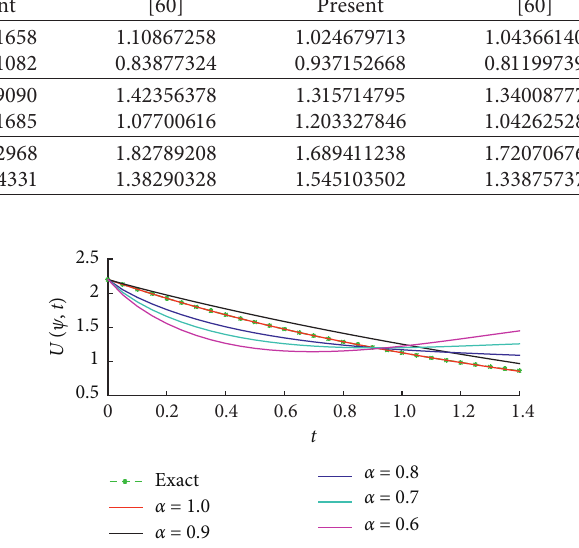
Figure 1: Plots of the approximate solution at ψ � 1 for different values of α .